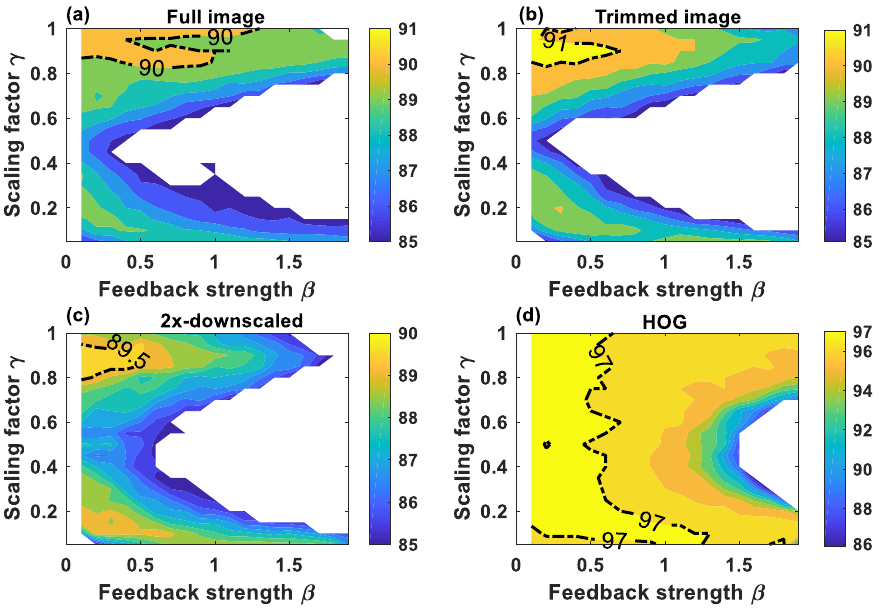
Figure 3. Evolution maps of the AR in parameter space of β - γ under φ = 0. ( a ) full image input with 1500 nodes, ( b ) trimmed image input with 700 nodes, ( c ) 2 × -downscaled features input with 200 nodes, and ( d ) HOG features input with 700 nodes.